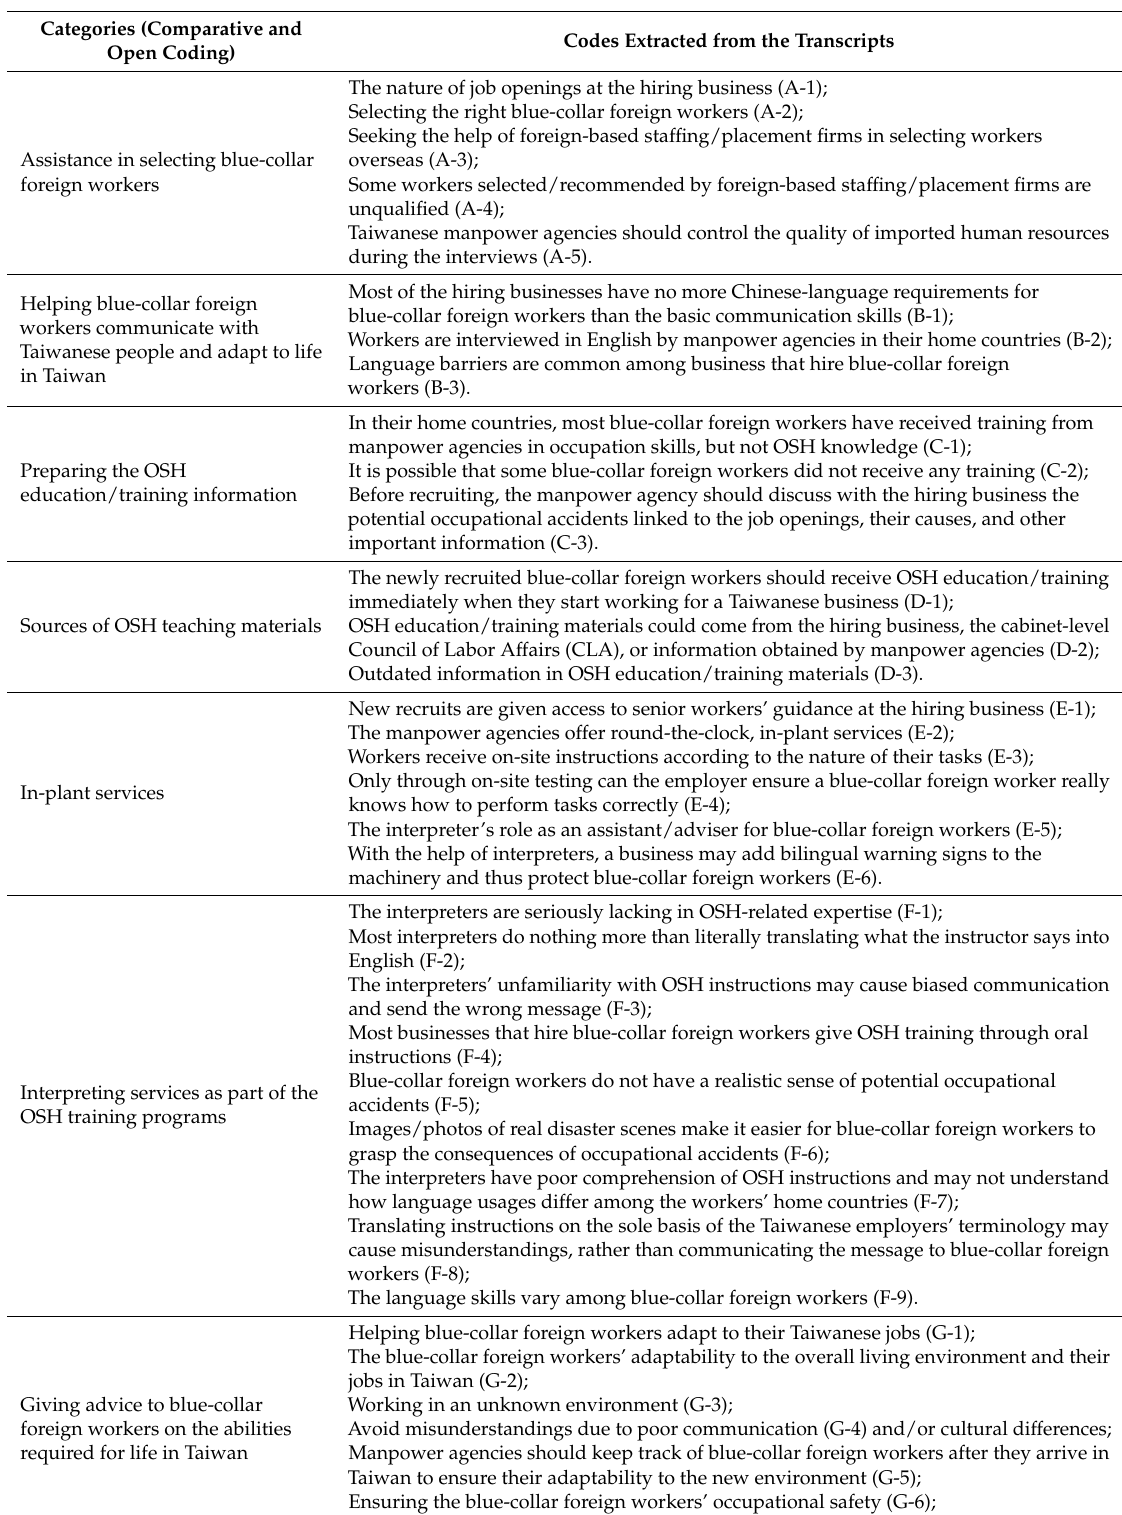
Table 2. Theoretical sampling as compared to comparative and open